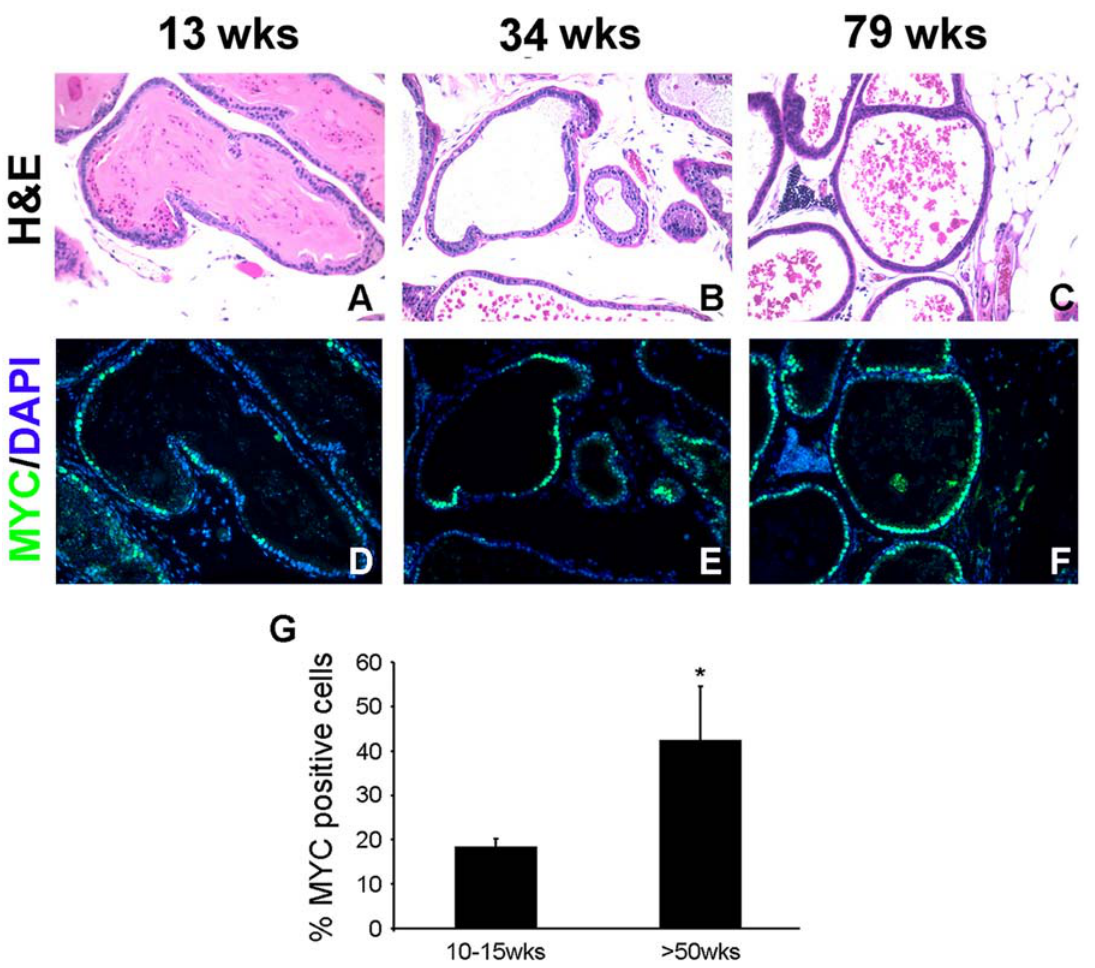
Figure 3. Time-dependent increase in c-MYC–expressing cells without discernible histopathology in a subset of PbCre4;Z-MYC mice. (A–C) H&E images demonstrate absence of histopathological abnormalities in PbCre4;Z-MYC prostates at various ages. (D–F) Adjacent sections subject to immunofluorescent staining for c-MYC demonstrate the numbers of c-MYC–overexpressing cells increase in a time-dependent manner. (G) The number of c-MYC–positive cells in any c-MYC–positive gland was quantitated based on the immunostaining shown in (D–F). N=3–4 prostate samples per group. * p , 0.05.